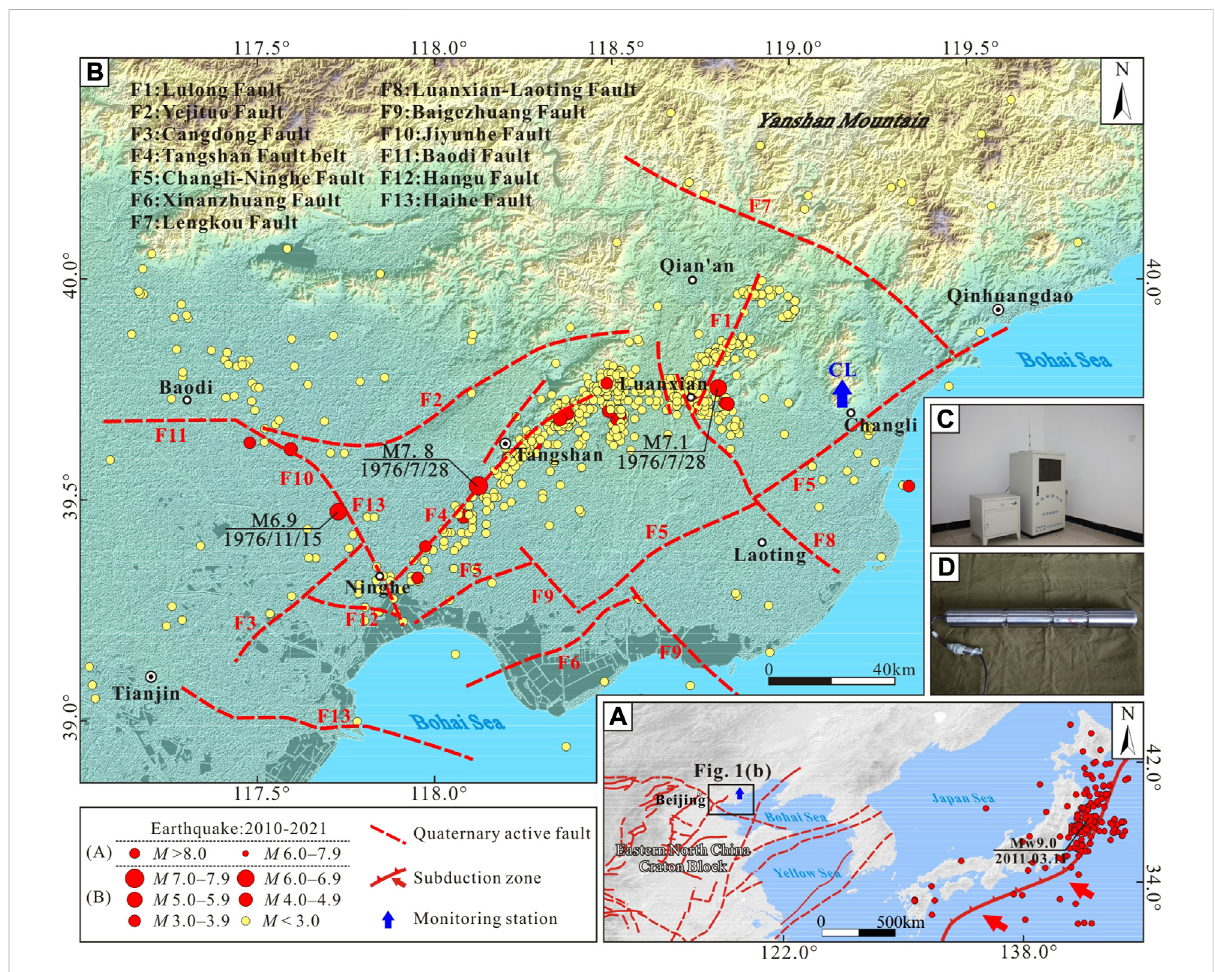
FIGURE 1 Regional structureof Tangshan seismic region andlocationofChanglipiezomagnetic stressmonitoring station (A) Regionalstructure diagram, (B) The distribution of faults in the Tangshan seismic region and the location of Changli station, (C) Ground Equipment for Piezomagnetic stress monitoring system, (D) Downhole Equipment for Piezomagnetic stress monitoring